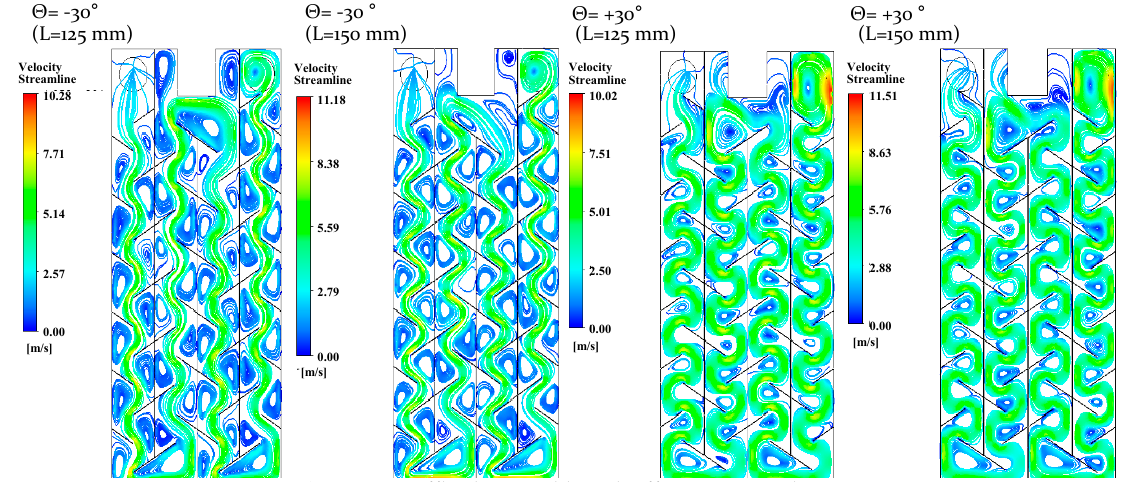
Figure 10. Baffle slope and length effect on streamlines Figure 10. Ba ffl e slope and length e ff ect on streamlines. Table 6. Ba ffl e length sensitivity numerical